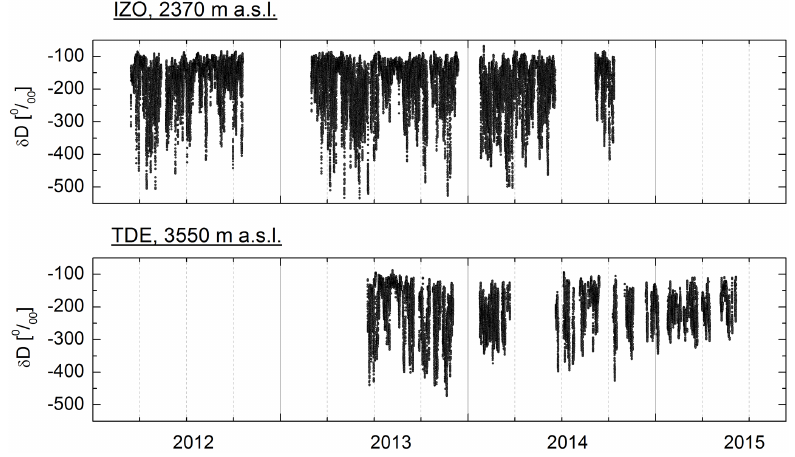
Figure 2. Time periods covered by water isotopologue in situ observations at IZO (upper panel) and TDE (lower panel). All 10min averages of δ D measured at any time of the day are shown